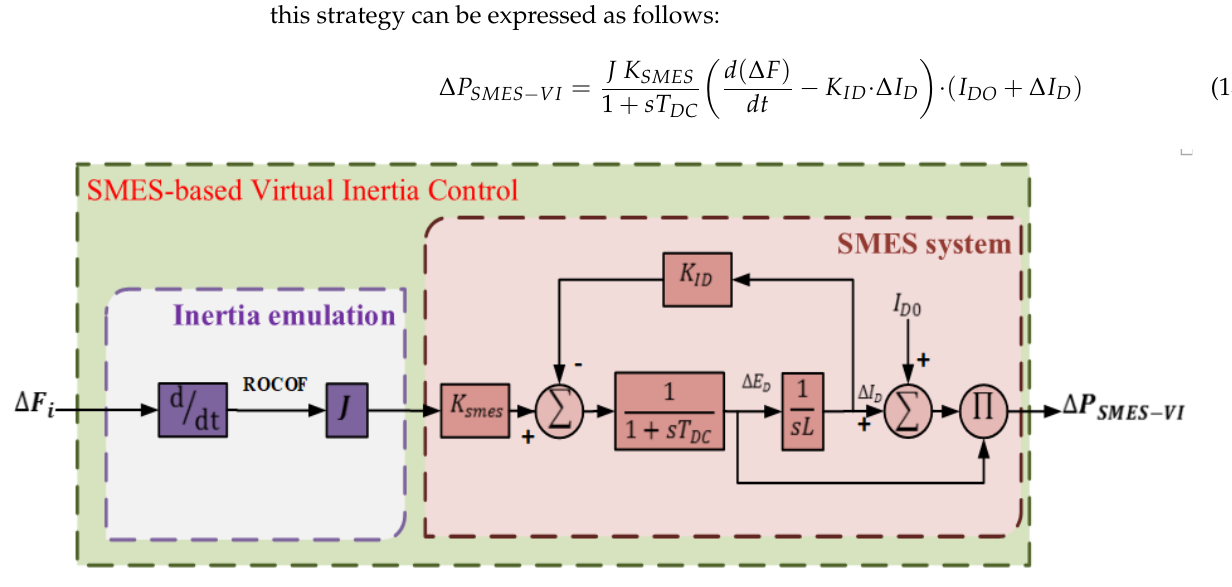
Figure 6. The dynamic model of VIC-based SMES technology.